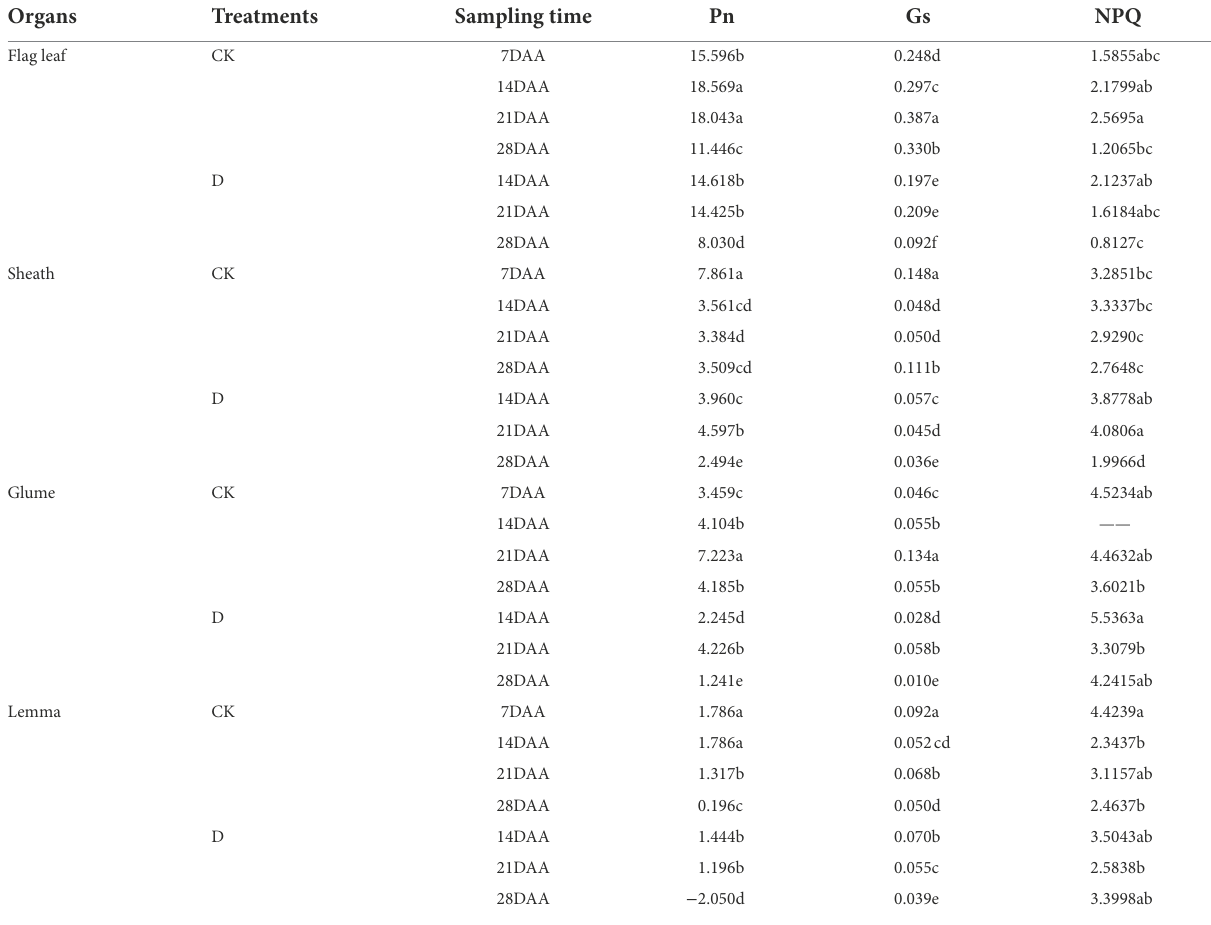
TABLE 4 Photosynthetic parameters in the flag leaf, the sheath, the glume and the lemma under drought stress.